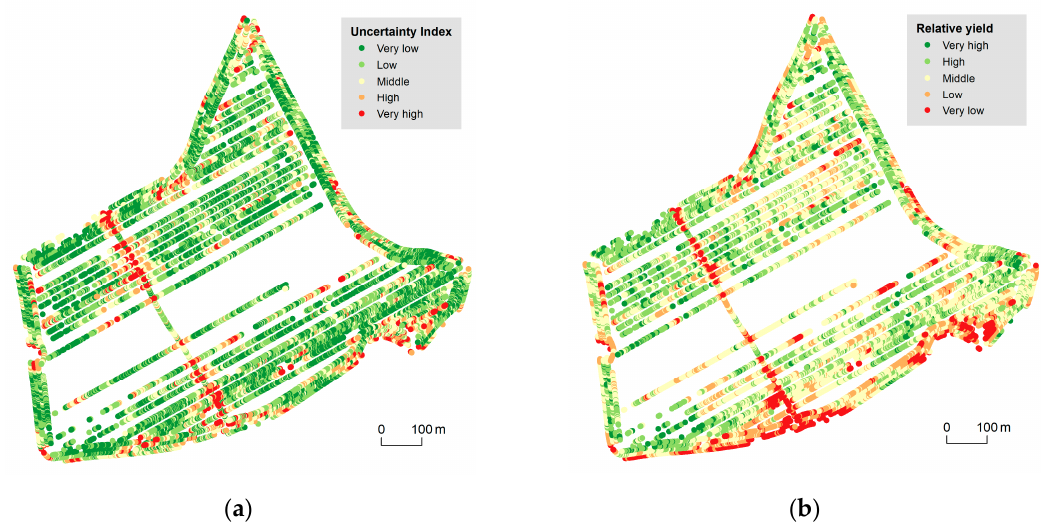
Figure 6. The extended traffic light metaphor for qualitative data on uncertainty ( a ) and yield ( b ) for the P ř ední prost ř ední plot.